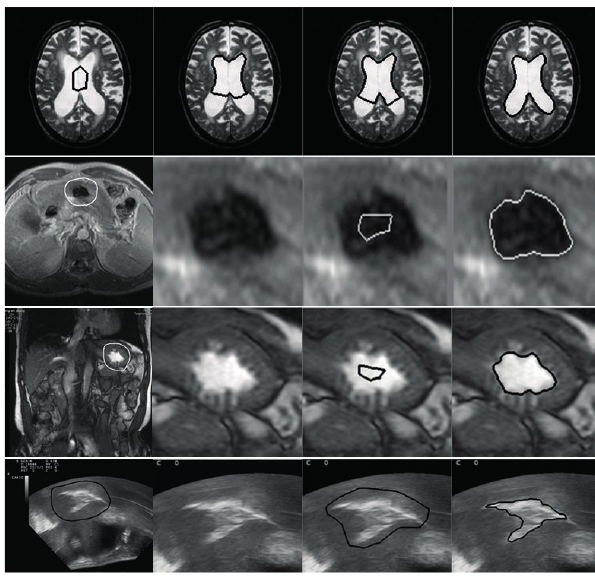
Figure 10: Experiments on MRI and ultrasound